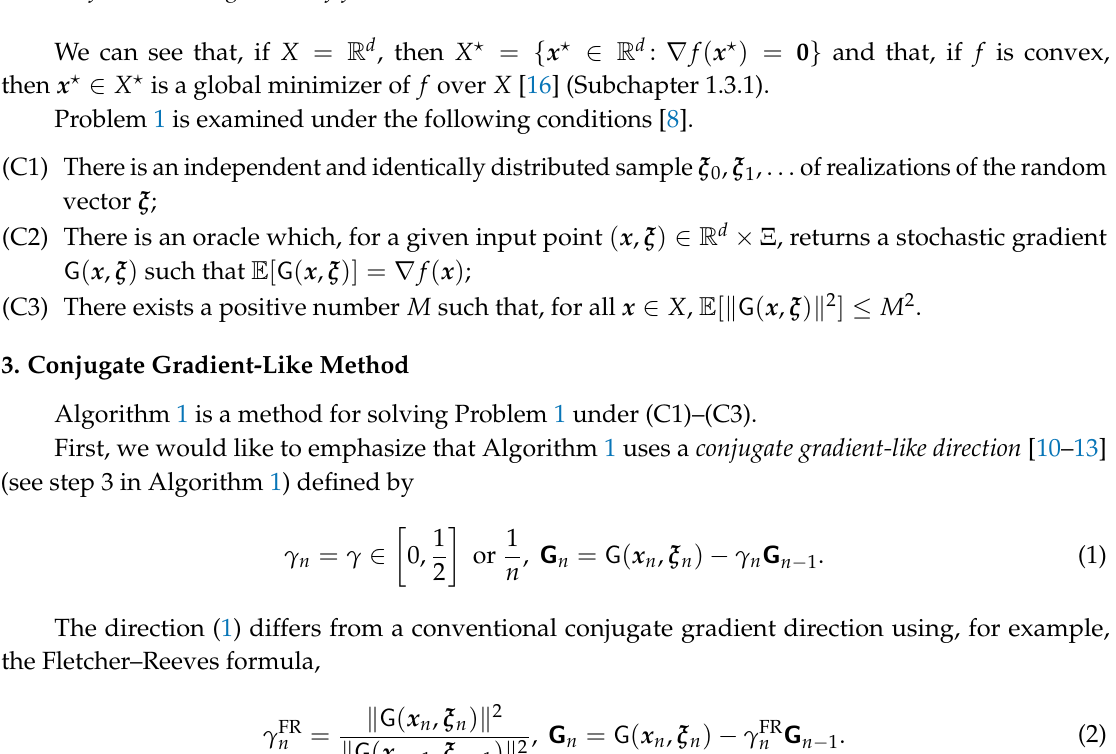
Algorithm 1 is a method for solving Problem 1 under